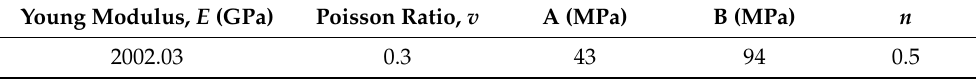
Table 1. Elastic and plastic material constants of polypropylene